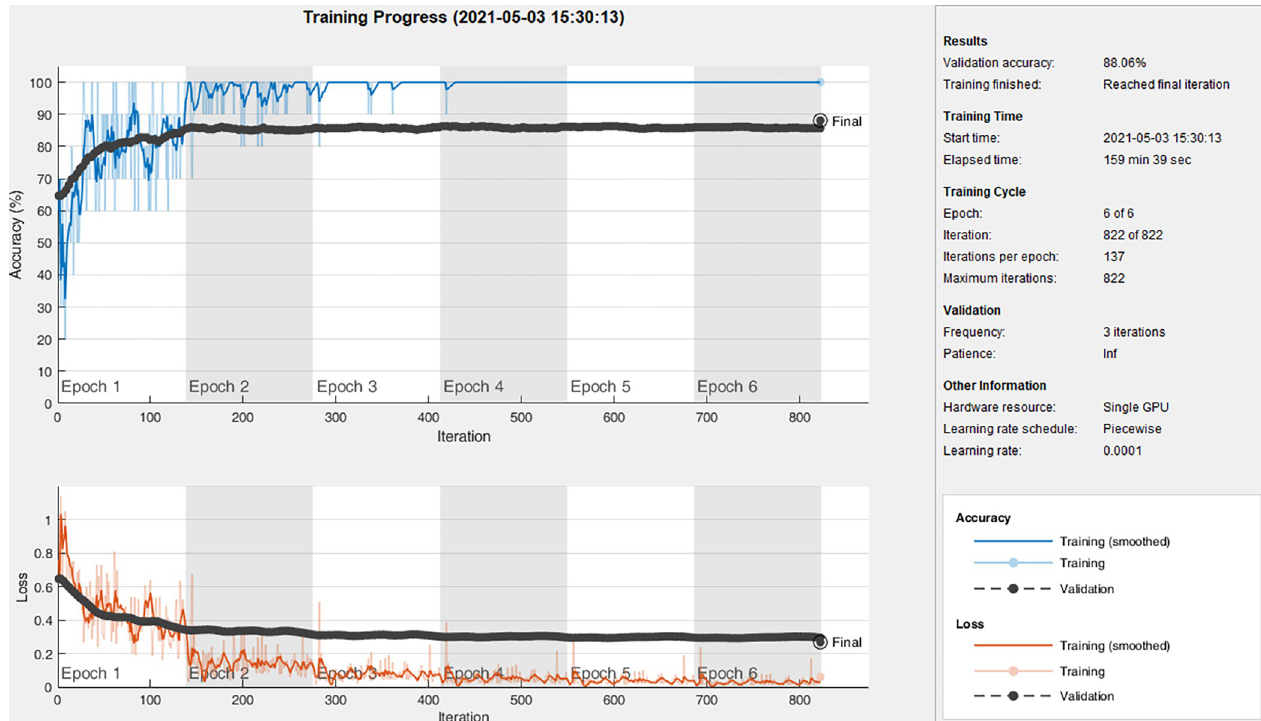
Fig 3. Accuracy and loss curves of DenseNet201 at 40 × in